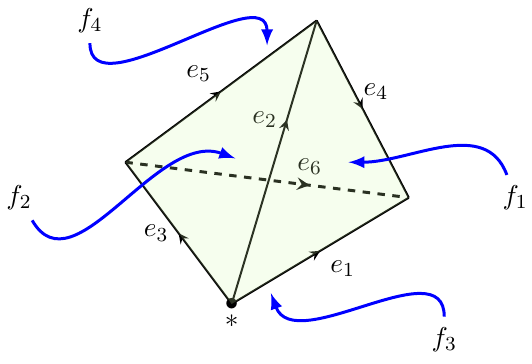
Figure 10 . Tetrahedron as an example of a triangulation of a 2 -sphere. Chosen orientations of edges are indicated by arrows.